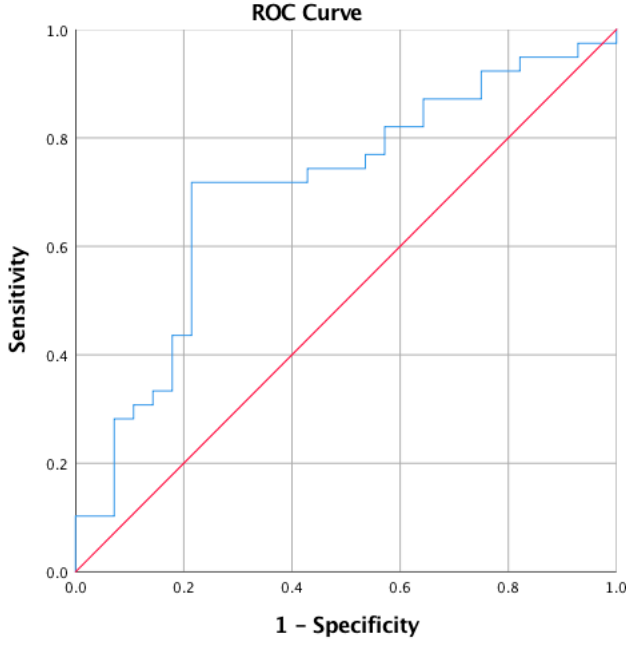
Figure 6 . ROC curve for short sclerotic line <12